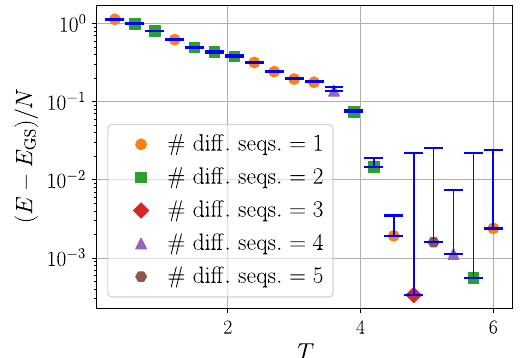
FIG. 8. Spin- 1 = 2 Ising model: protocol generalization across various system sizes. The marker types show the number of different protocols found by the RL agent at a fixed T across all system sizes N ¼ 6 , 10, 12, 14, 16, and 18. Each protocol is applied to every system size N at a fixed T , which results in a set of cost function values; the error bars designate the range between the largest and smallest cost function values. The parameters are the same as in Fig.